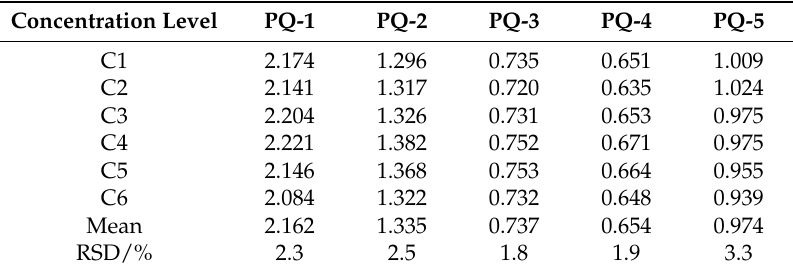
Table 3. Results of RCFs ( f x ) for the five analytes PQ-1 through PQ-5 1 .